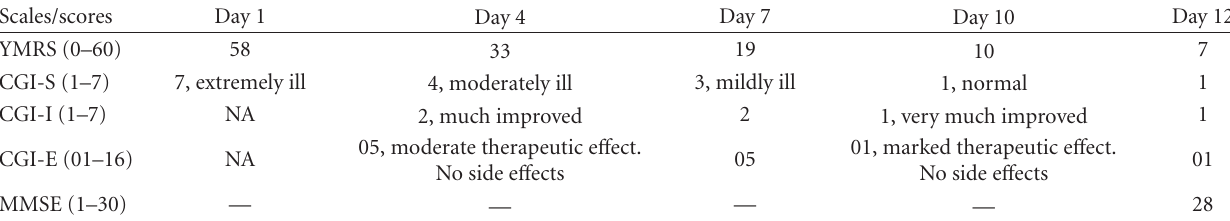
Table 1: Assessments at various time points in our patient.